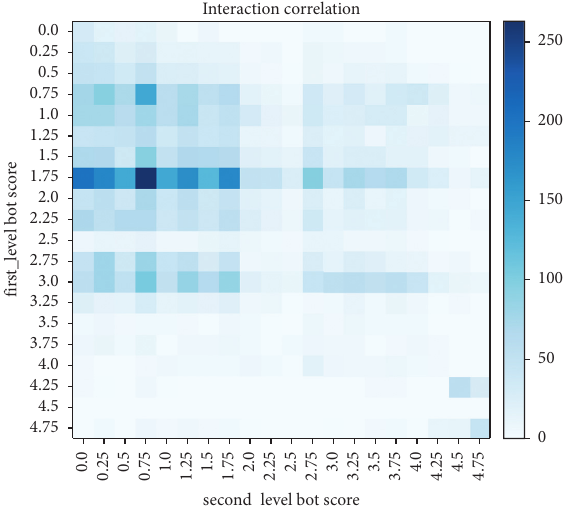
Figure 7: Distribution of forwarding between users with different bot scores.